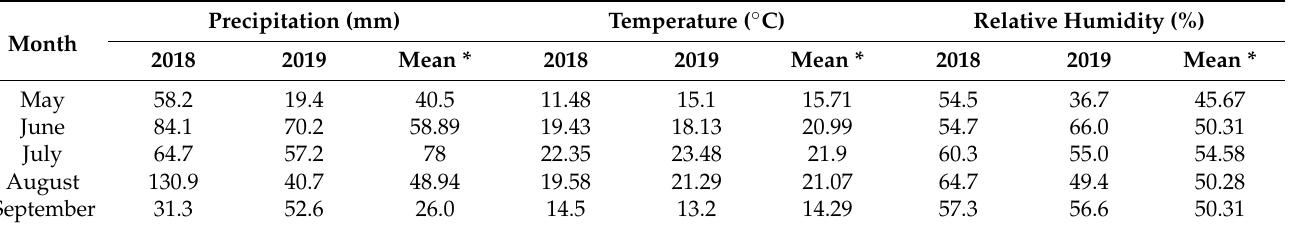
Table 2. Climatic data of Nur Sultan, Kazakhstan for the duration of the study and comparison with mean monthly data.